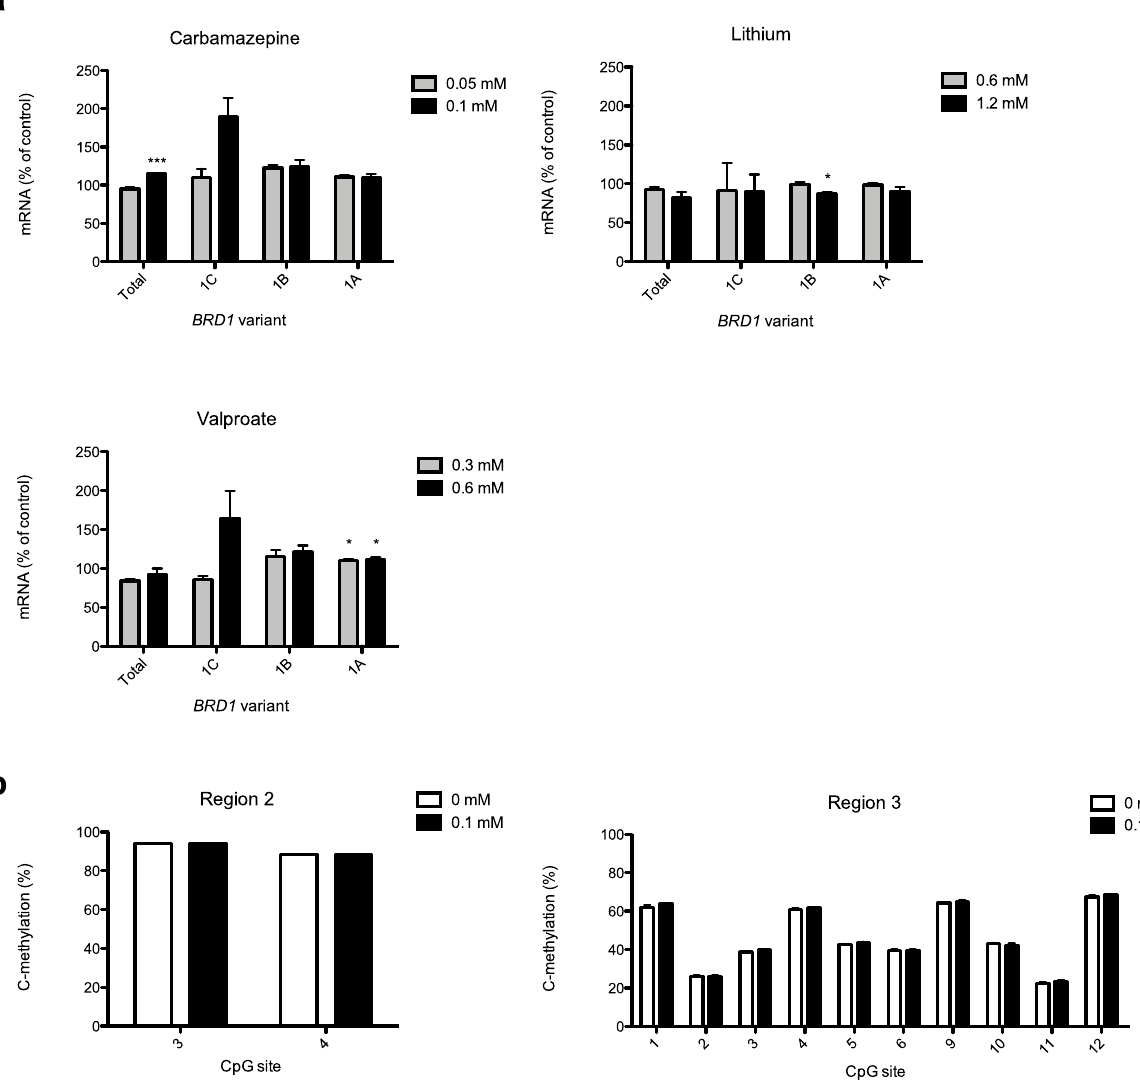
Fig 5. Expression of BRD1 transcripts and methylation proportions in region 2 and 3 in SH-SY5Y cells following drug treatment. (a) Expression of BRD1 transcripts in SH-SY5Y cells followingLithium, Valproate,and Carbamazepine treatment. The total BRD1 expressionand expressionof transcript variants containingexon 1C, 1B, and 1A were measuredin RNA extracted from control cells or followingexposure of the cells to the lowest and highesttherapeuticdosageof the drugs for 72 hours in SH-SY5Y cells. Data are presented as mean percentages of the mean value of the control group (no drug treatment) +SEM (n = 3/group). *** p < 0.001, one-wayANOVA with Dunnett’s post-hoc tests. (b) Methylationproportions as determined by pyrosequencing of region2 and 3 followingCarbamazepine treatment in SH-SY5Y cells. Methylationproportions were measuredby pyrosequencing of region2 and 3 in DNA extracted from SH-SY5Y cells followingexposureto 0 or 0.1 mM Carbamazepine for 72 hours. Data are presentedas mean cytosine methylationproportions (C- methylation) at each CpG site +SEM (n = 3/group). Group means were comparedby